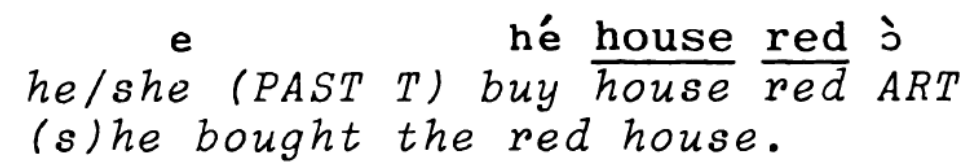
Figure 1 . Insertion of English adjective between Adã ŋ me noun and Adã ŋ me determiner (from Nartey 1982, p. 187, example 4).